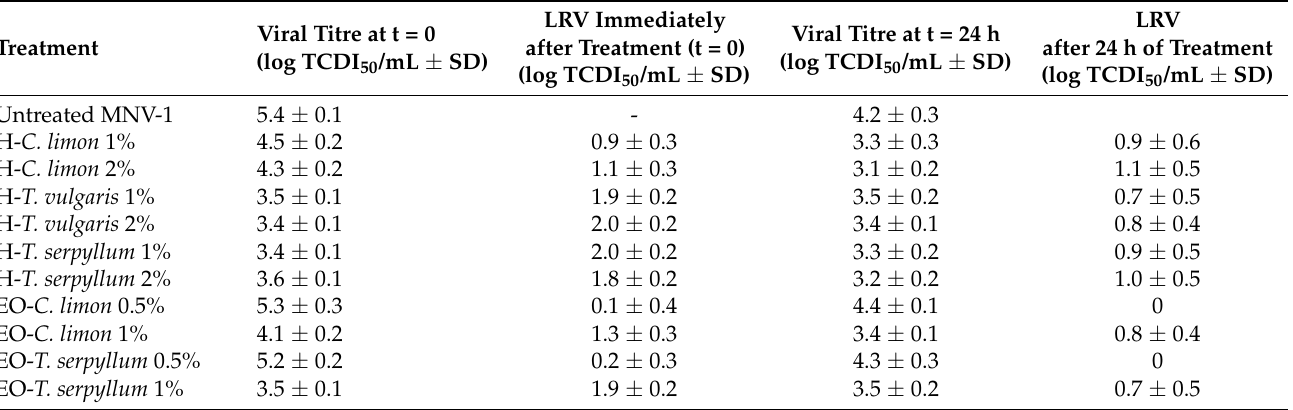
Table 4. In vitro effect of C. limon, T. vulgaris, T. serpyllum hydrolates (H), and of C. limon, T. serpyllum EOs on MNV-1 infectivity immediately after treatment and after 24 h of incubation at 20 ± 2 ◦ C by calculating log reduction value